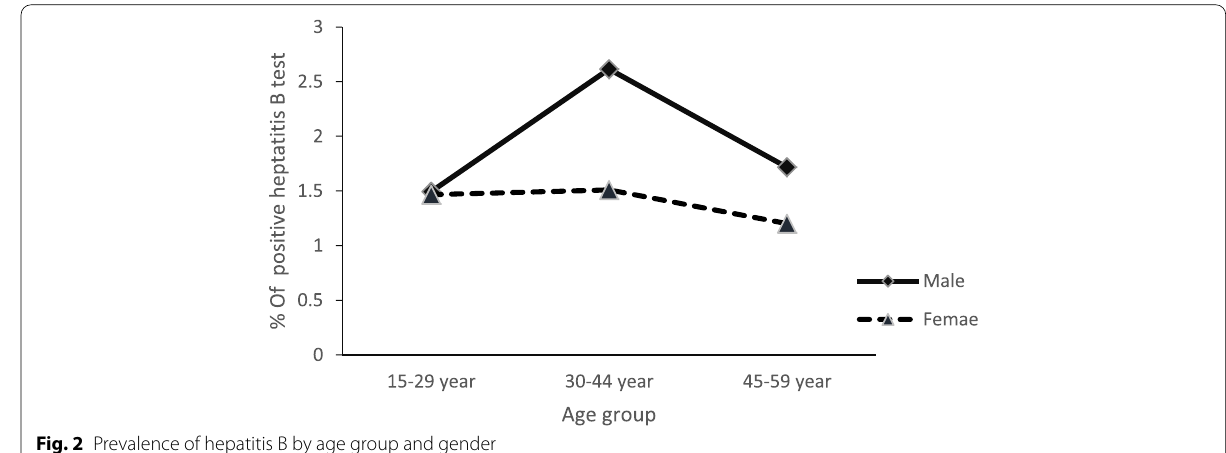
Fig. 2 Prevalence of hepatitis B by age group and